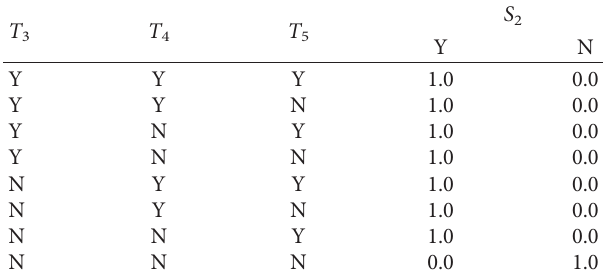
Table 2: Parameter configuration for S